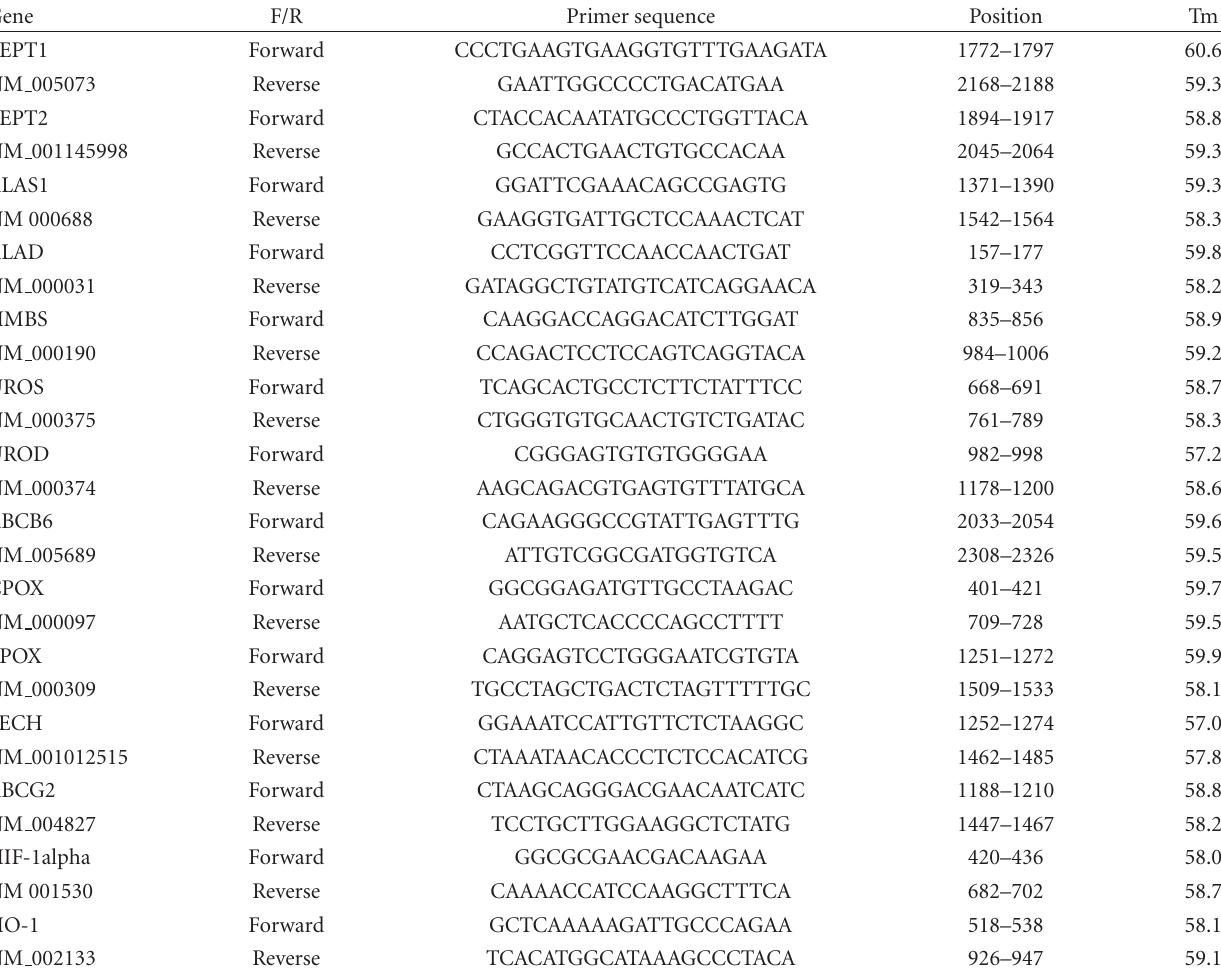
Table 1: PCR primers to quantitatively measure the mRNA levels of PEPT1, PEPT2, ALAS1, ALAD, HMBS, UROS, UROD, ABCB6 CPOX, PPOX, ABCG2, FECH, HO-1, and